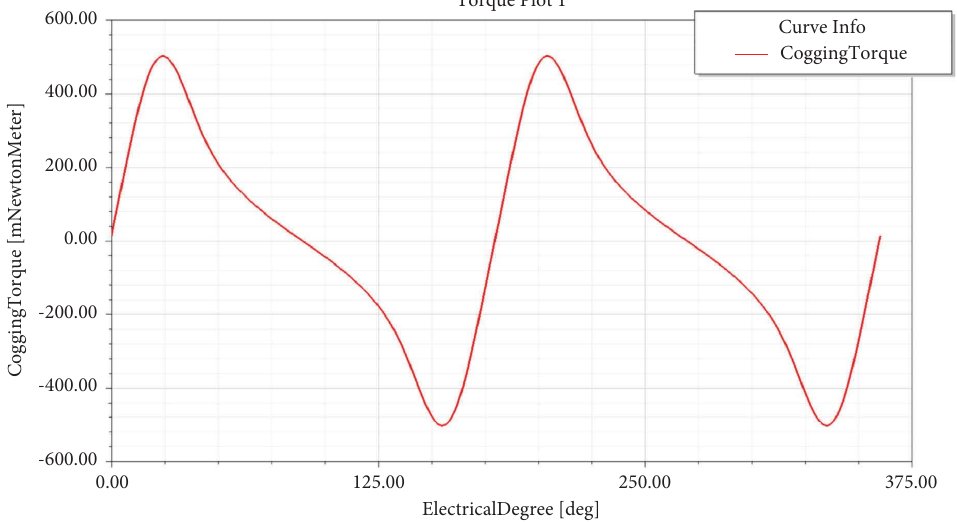
Figure 4: Torque curve of 4-pole 24-slot motor.